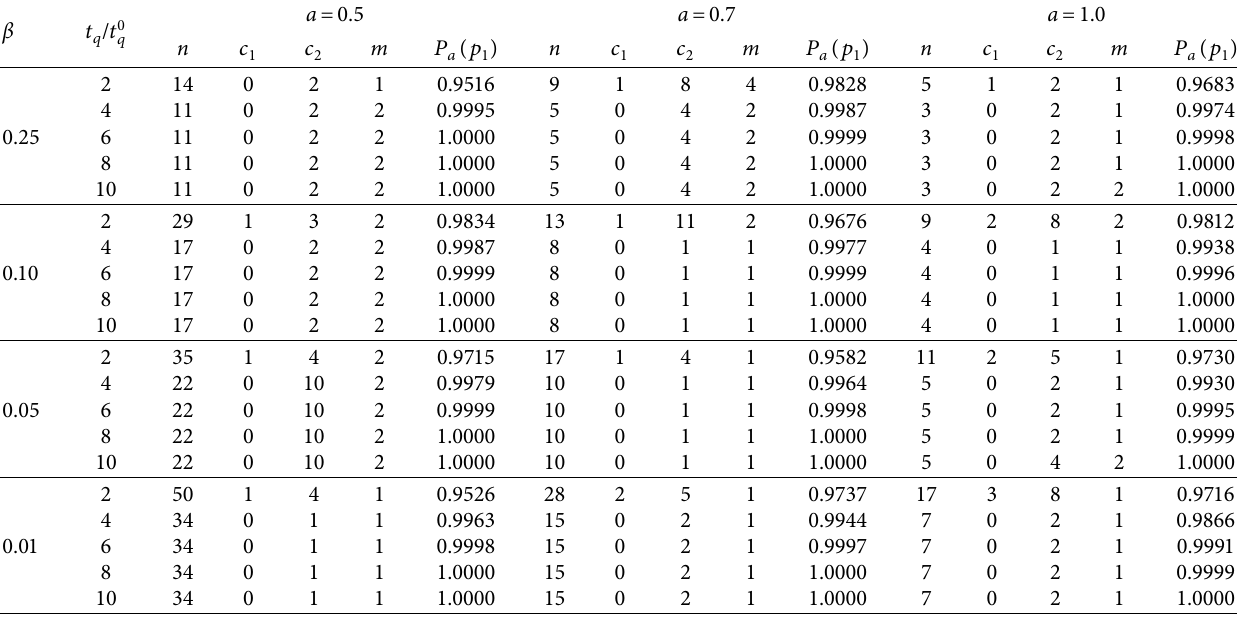
Table 6: Optimal parameters of the proposed MDSSP for EWD with δ � 4 . 4859 , c � 0 . 9525 at 50 th